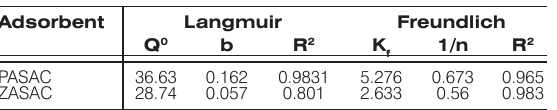
Table 4. Comparison of adsorption capacity with other adsorbents Adsorbent